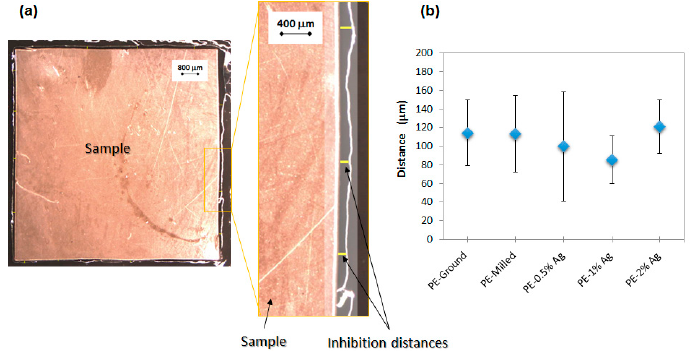
Figure 4. ( a ) Optical microscopy images illustrating how inhibition distances were calculated and ( b ) the results of average inhibition distances obtained for each material.